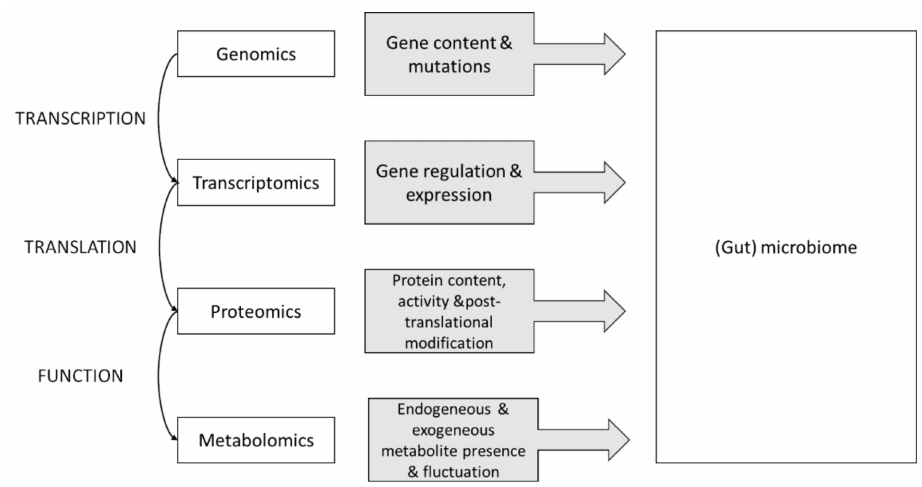
Figure 1. Schematic representation showing the integration of the different omics technology (white boxes on the left) and their roles and interactions (grey boxes, center) with the gut microbiome, adapted from